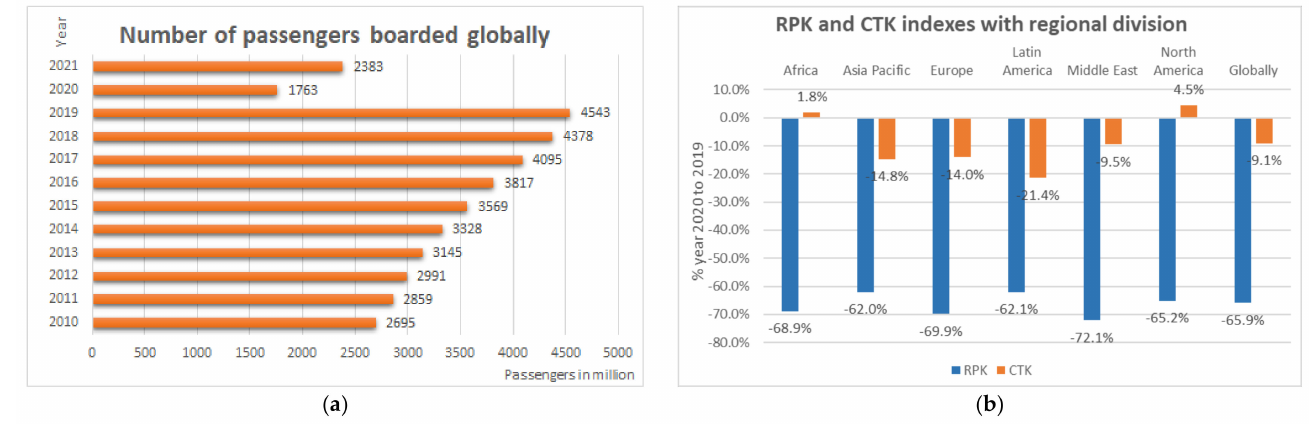
Figure 1. Background of the research: ( a ) Number of passengers boarded globally, years 2010–2021, own work based on [3]; ( b ) Passengers and cargo indexes with regional division, % year 2020 versus year 2019, own work based on [1].